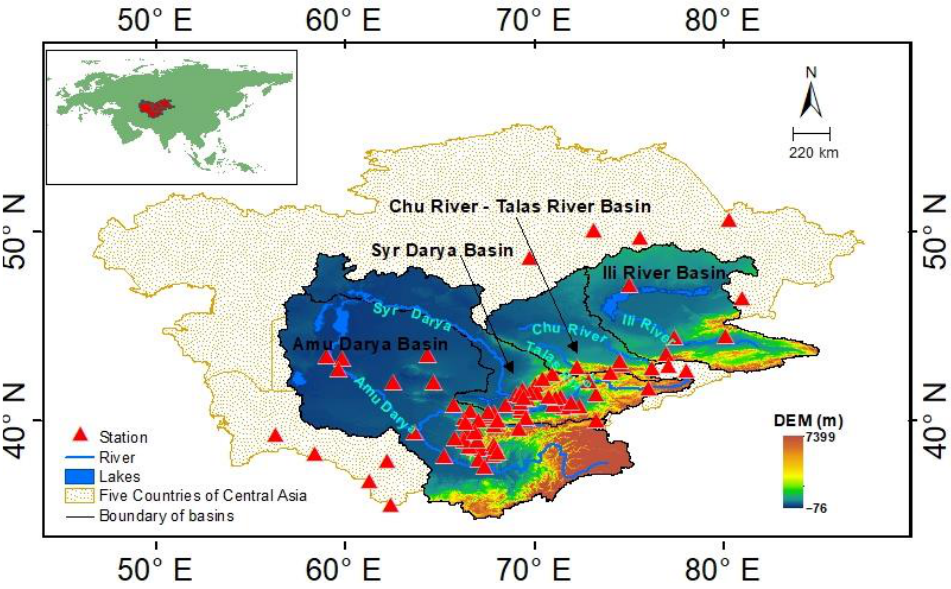
Figure 1. Distribution map of four basins in Central Asia.